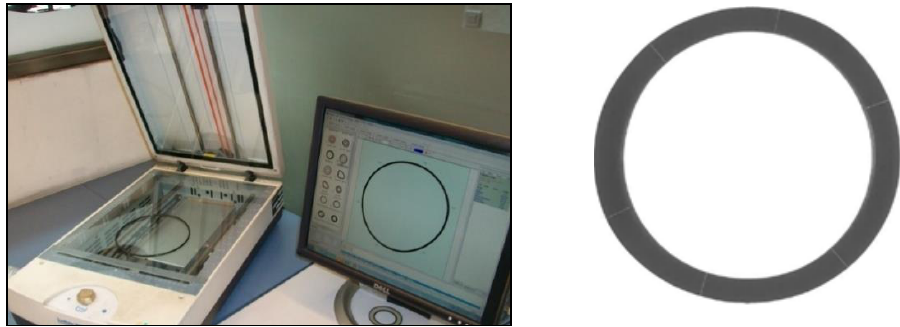
Figure 2. Dimensional checking procedure and example of measurement.